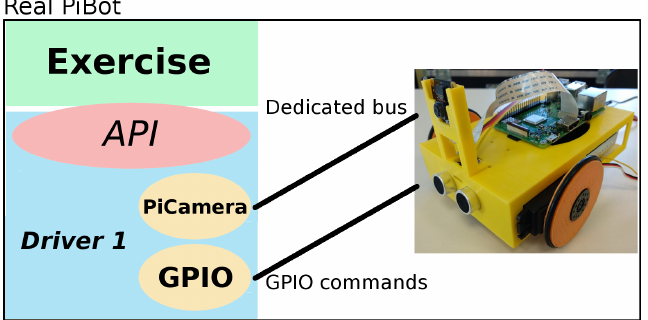
Figure 8. Connection of the library with the real PiBot .